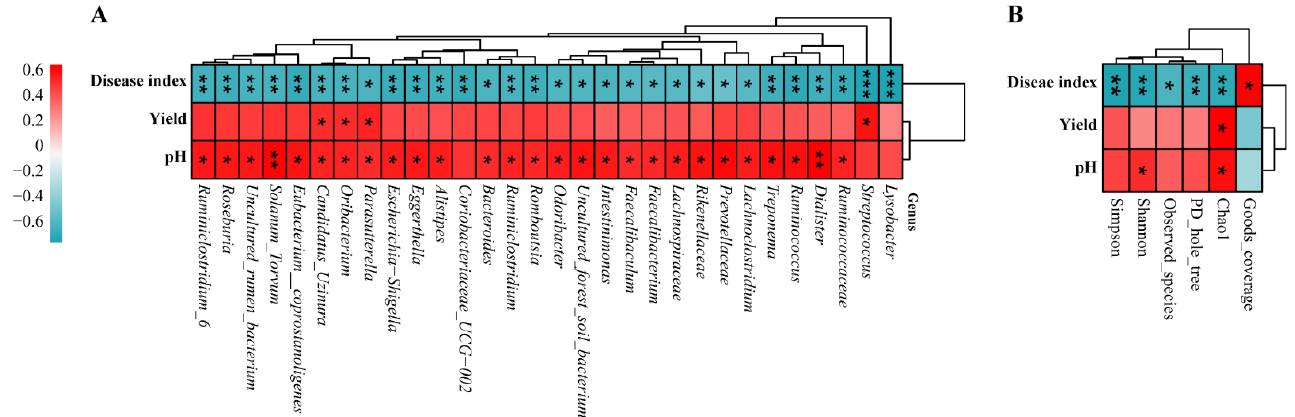
Figure 6. Correlation analysis of disease index, yield, and pH between bacterial genera and diversity indices. Correlation analysis of disease index, yield, and pH between bacterial genera ( A ) and correlation analysis of disease index, yield, and pH between alpha diversity indices ( B ). Asterisks represents the significant differences among treatments according to t -test at * p < 0.05, ** p < 0.01, and *** p < 0.001.